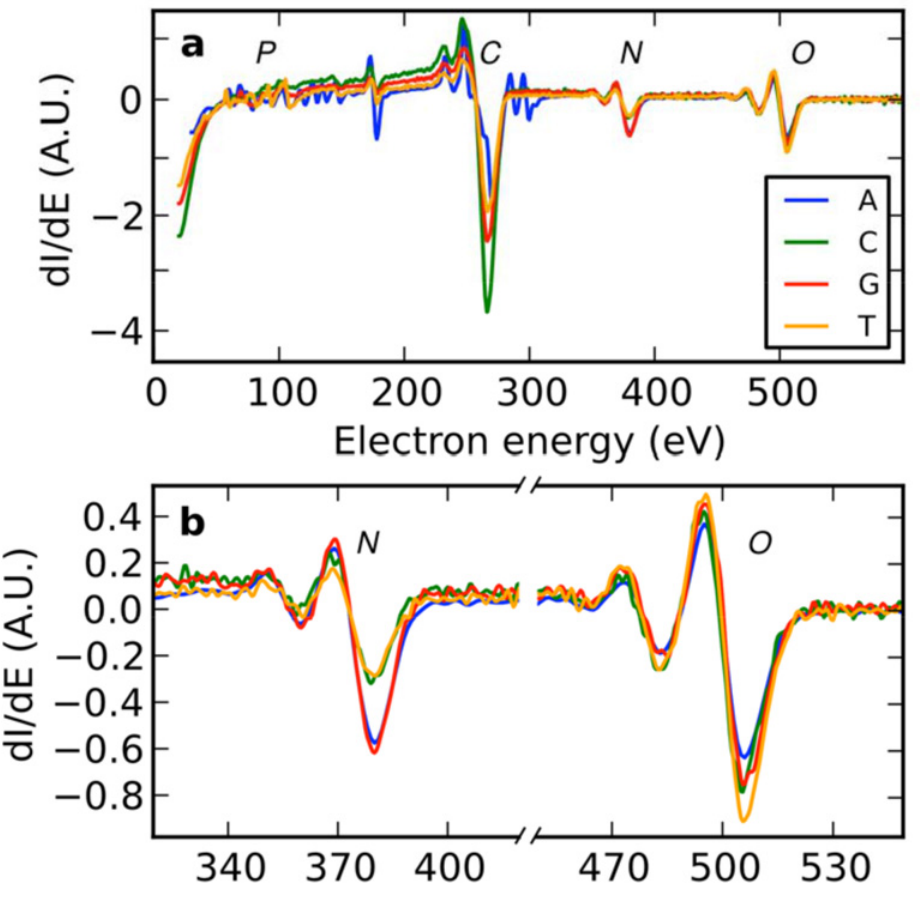
Fig 6. Auger spectra for single-stranded homopolymeric 5mers. Peak positions for phosphor (LMM 120 eV), carbon (KLL 272 eV), nitrogen (KLL 379 eV) and oxygen (KLL 503 eV) are marked with the respective elemental symbols. Spectra are normalized to obtain the expected ratio of oxygen (A:C:G:T = 5:6:6:7) as shown in Fig 1. Panel a shows an overview of detected electrons in the 30 – 600 eV range, and panel b shows zoom-ins of the nitrogen and oxygen